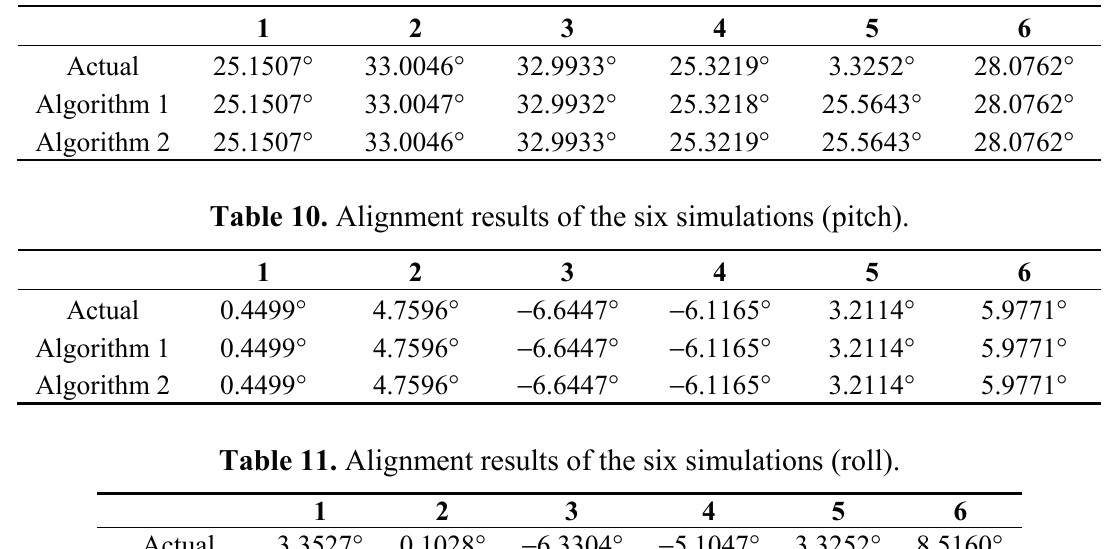
Table 9. Alignment results of the six simulations (heading).